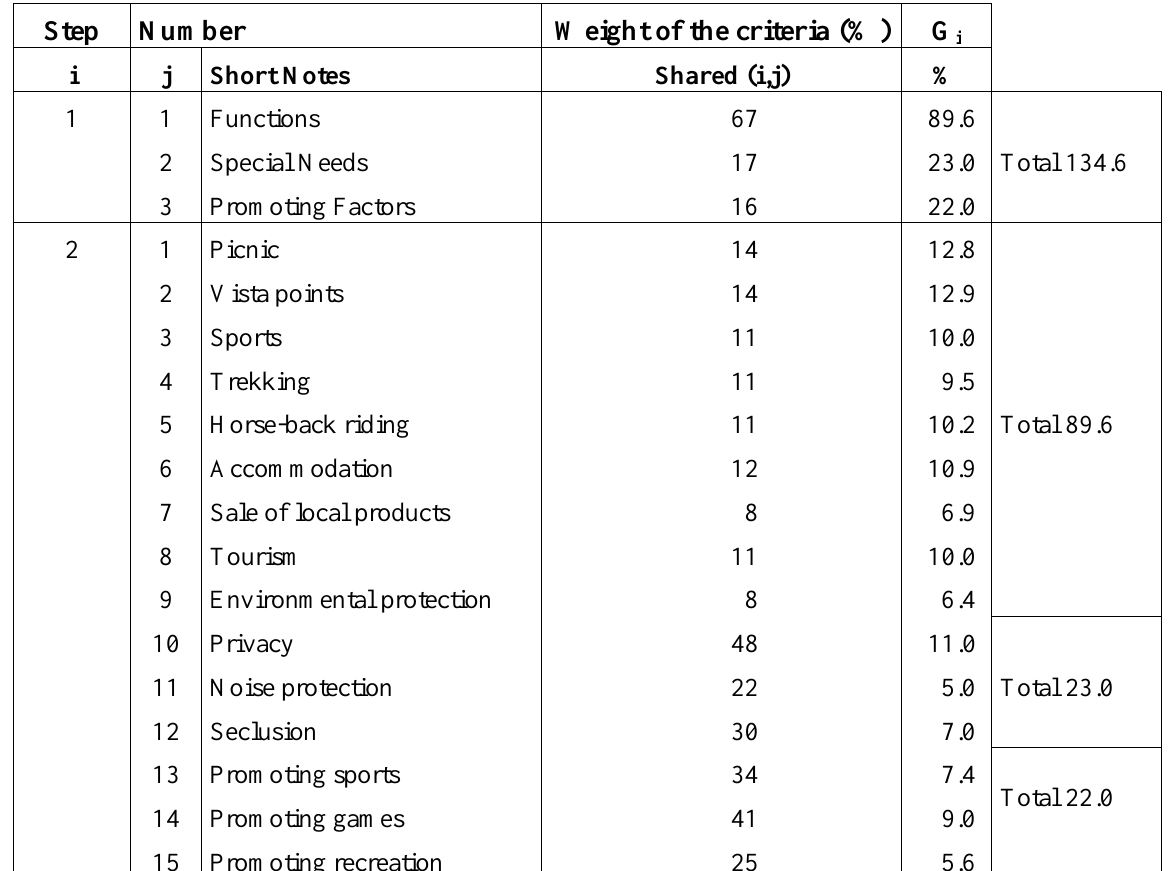
Table 5. Weighted explanation of the